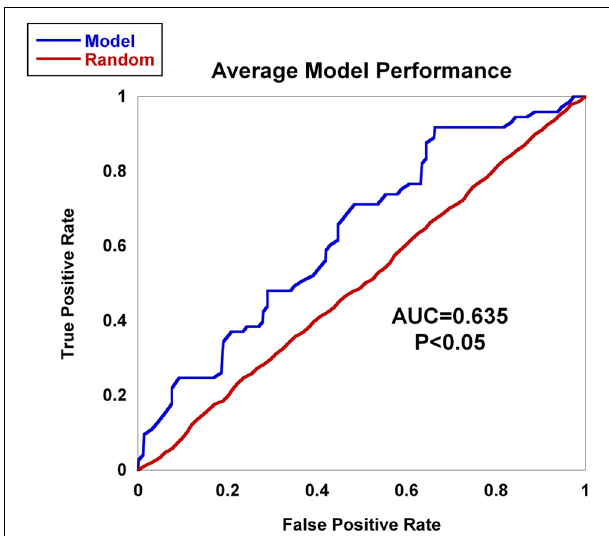
FIGURE 8 | AUC for inflammatory arthritis prediction study for the Marshfield population. The Naïve Bayes classifier developed using data from the literature was applied to the Marshfield population of inflammatory arthritis individuals: Rheumatoid arthritis (RA), Psoriatic arthritis (PsA), and Ankylosing spondylitis (AS). The model generated an AUC of 0.635, which was statistically significant via permutation. In addition, performance on randomized sample sets is shown in red, showing an expected null